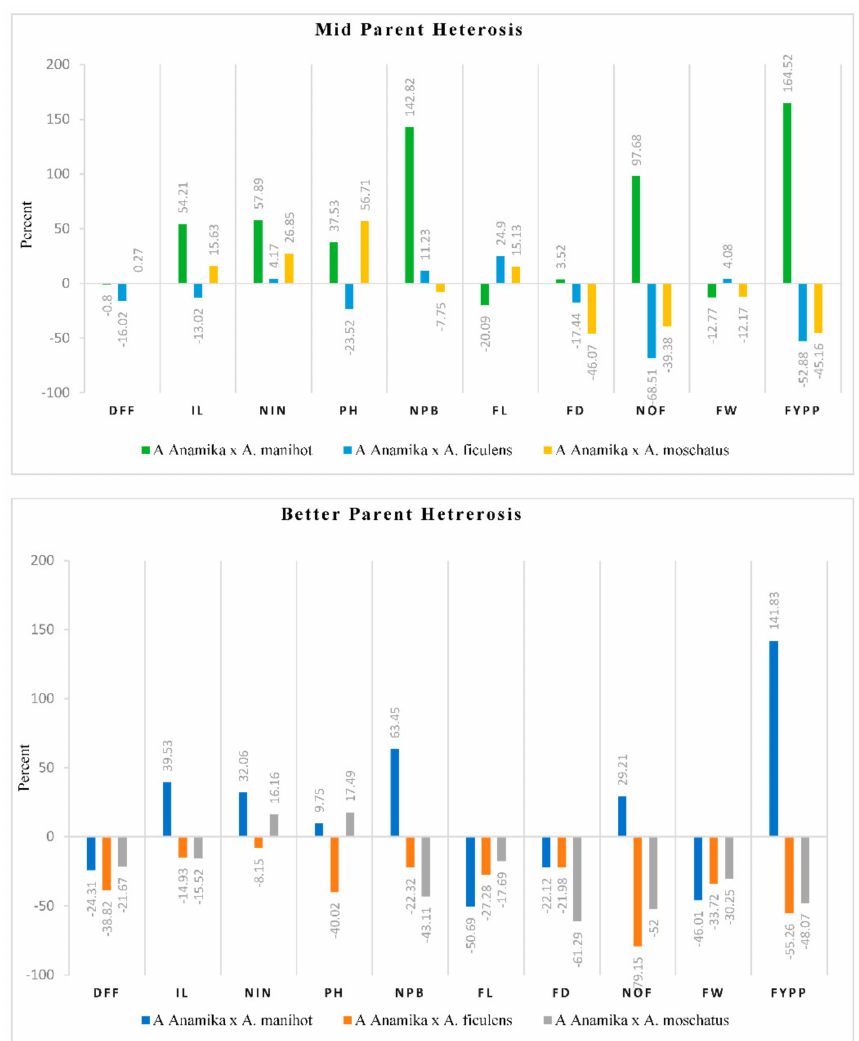
Figure 3. Range of heterosis over mid parent and better parent in the three interspecific crosses. DFF = Days to 50 per cent flowering, IL = Internodal length (cm), NIN = Number of internodes, PH = Plant height (cm), NPB = Number of primary branches, FL = Fruit length (cm), FD = Fruit diameter, NOF = Number of fruits per plant, FW = fruit weight (g) and FYPP = Fruit yield per plant